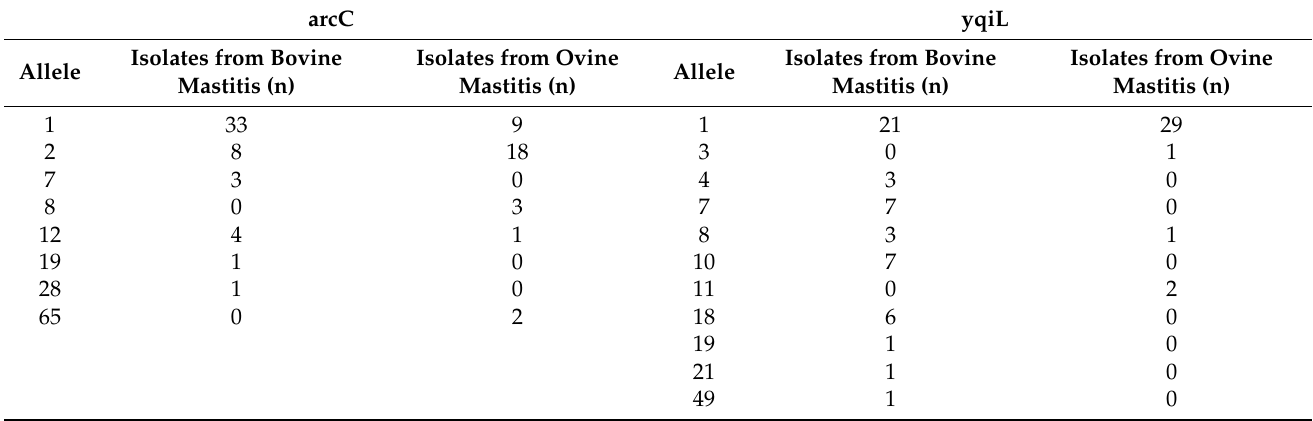
Table 2. Frequency of alleles of the genes arcC and yqiL in S. epidermidis isolates from cases of mastitis in the MLST database, recovered from cattle ( n = 50) or sheep ( n = 33). arcC